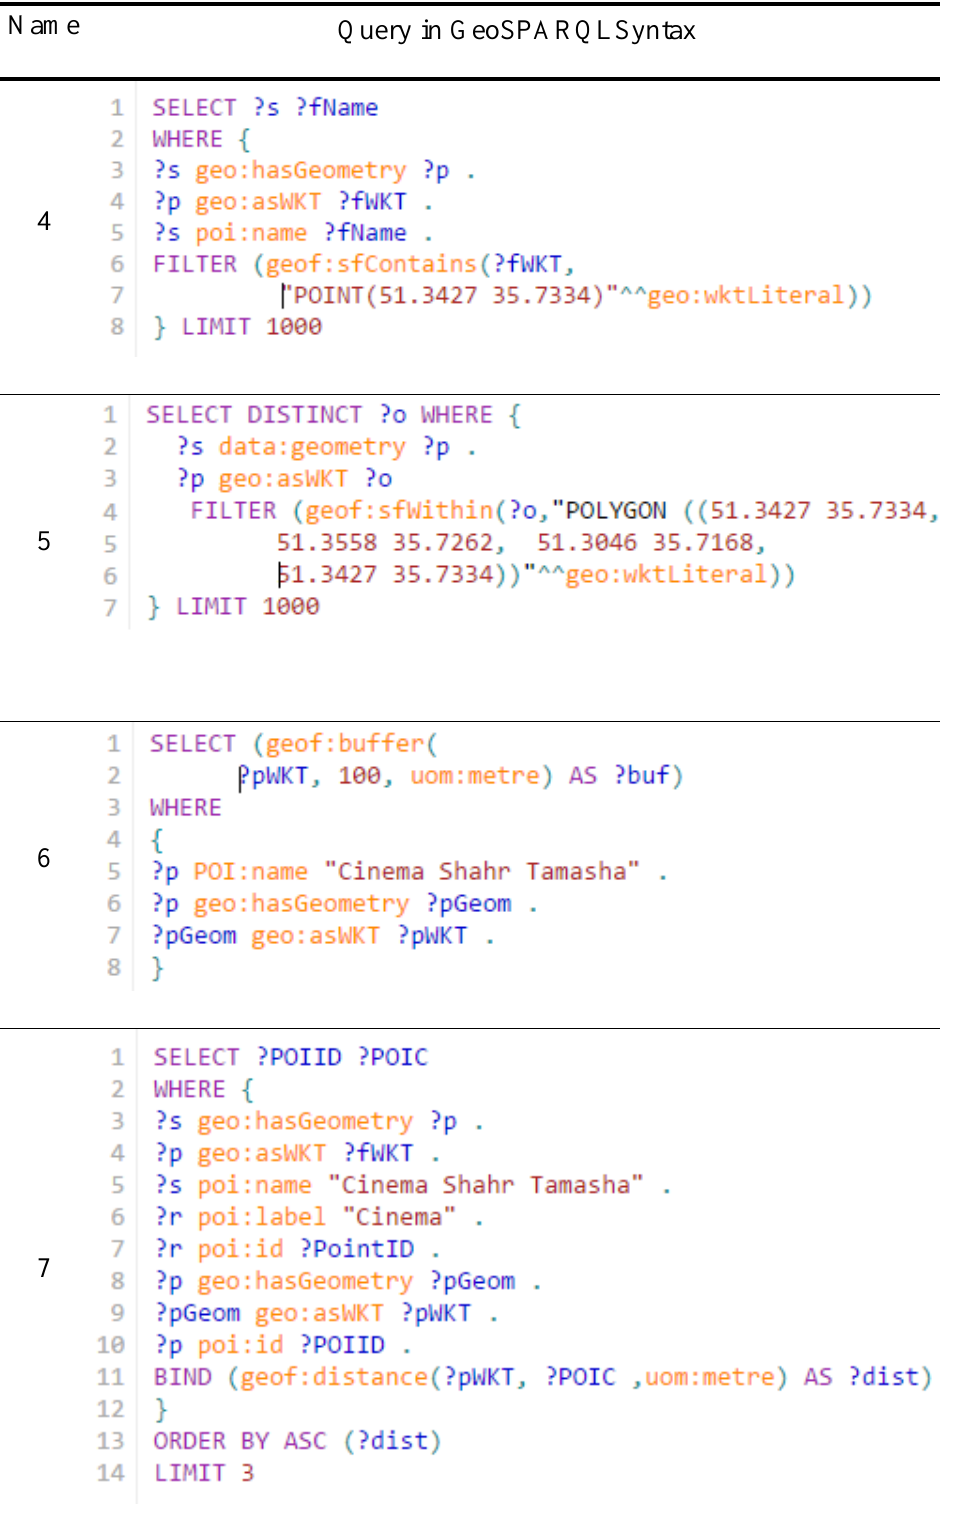
Table 2. Spatial semantic Operation and